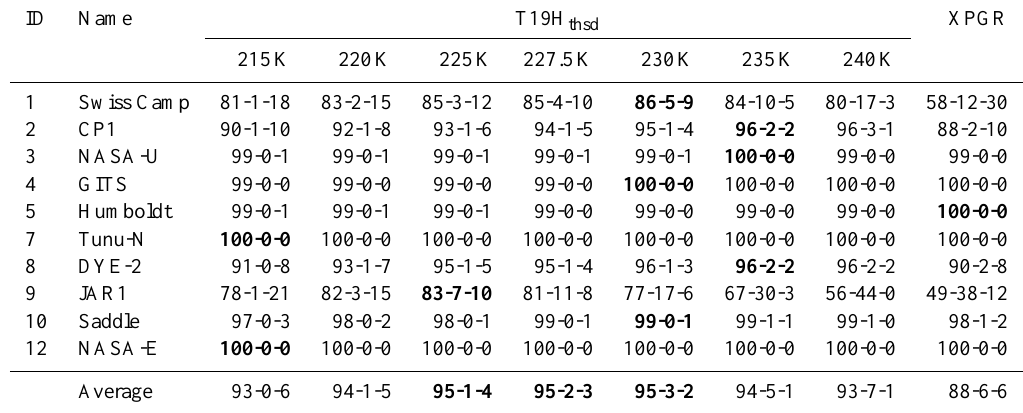
Table 3. The same as Table 1 but with the T19H-based algorithms for different values of T19H thsd . The best agreement is written in